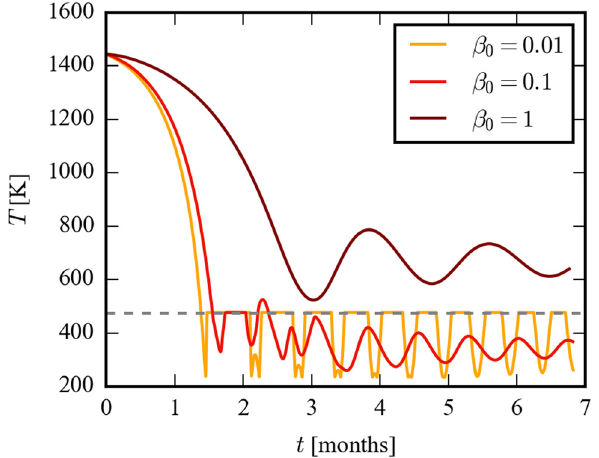
Figure 5: Dependence of the MFT ’ s temperature on time for various initial plasma beta β in presence of external magnetic fi eld. 0 Horizontal dashed line the delineates the temperature of the disk ’ s corona. Initial parameters: r 0.5 au